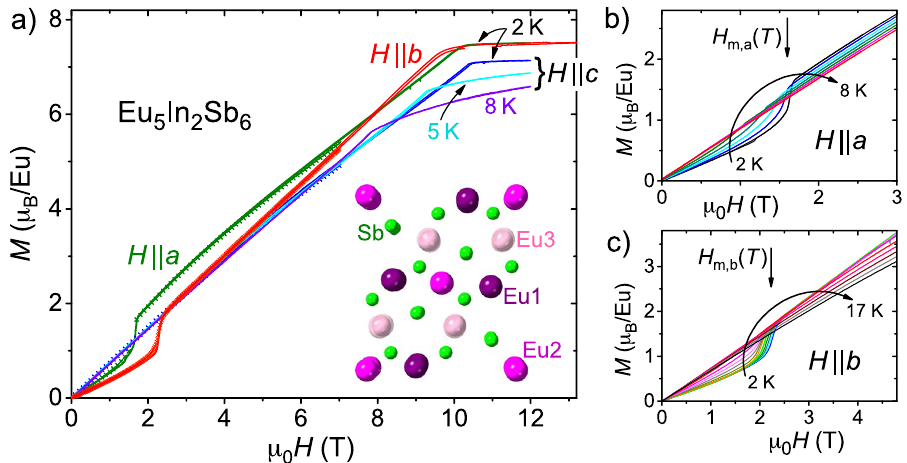
Figure 1. ( a ) Magnetization in dependence on magnetic field for up and down sweeps. Data at 2 K are shown for fields along all three crystallographic directions, for H (cid:31) c also data at 5 K and 8 K are presented. Lines indicate measurements up to 14 T, markers up to 7 T. Inset: Three groups of crystallographically different Eu positions (reddish color, marked Eu1, Eu2 and Eu3) within the crystal structure of Eu 5 In 2 Sb 6 (Sb in green, In not shown) viewed along the c -axis. ( b , c ) Temperature evolution (in steps of 1 K) of magnetization curves for H (cid:31) a and H (cid:31) b emphasizing the metamagnetic transitions at H m ( T ) (arrows).